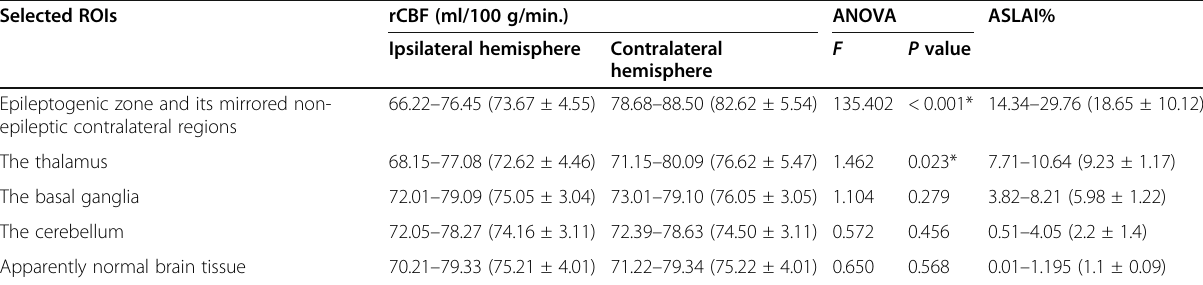
Table 4 Quantitative analysis of the PASL-MRI results of both cerebral hemispheres of the studied patients ( n = 26) Selected ROIs rCBF (ml/100 g/min.)